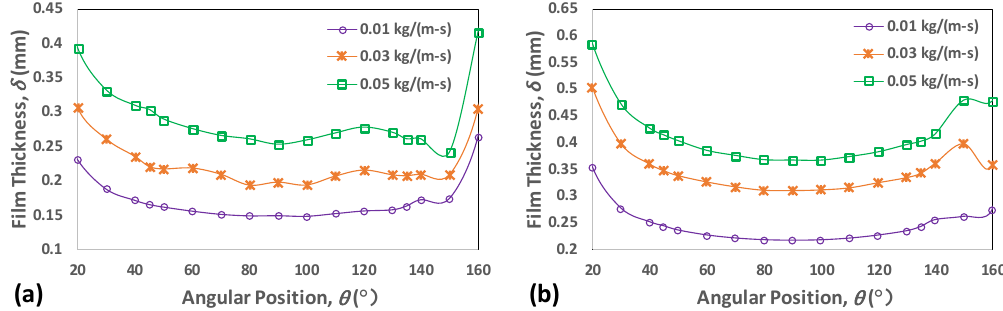
Figure 8. Film thickness distribution w.r.t. liquid load for ( a ) C = 0.45 and ( b ) C = 0.65.